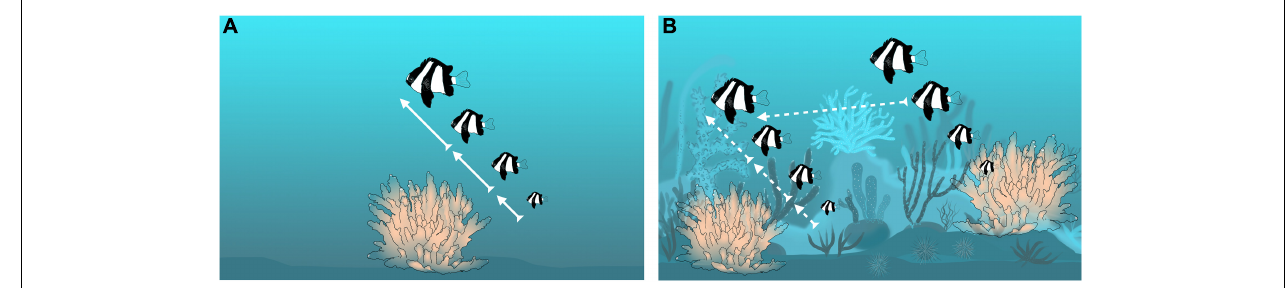
FIGURE 3 | Relationship between ecological constraints and territory inheritance within groups of Dascyllus aruanus ; arrows represent changes in rank via inheritance or movement (bold continuous arrows show high probability of territory inheritance in the group; dashed arrows show some lower probability of territory inheritance in the group and some probability of inheritance via movement from the neighboring group). (A) Patchy habitat with strong ecological constraints, little movement and high probability of territory inheritance; (B) More continuous habitat, with weak ecological constraints, lots of movement, and lower probability of territory